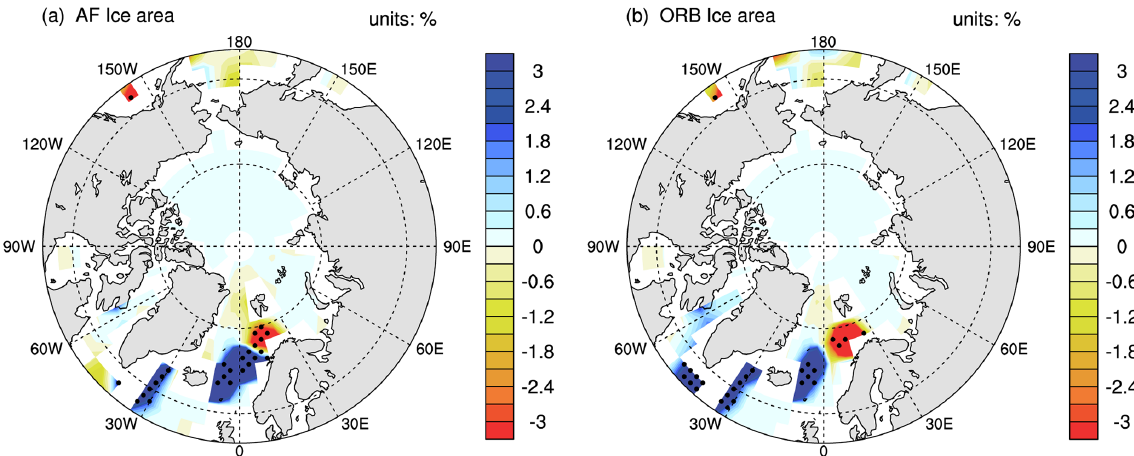
Figure 4. (a) The March sea ice area changes between two period (0–2 and 5–8ka) in the NNU-Hol All forcing simulation (regional average in the Pacific Arctic, 0.02%, and the Atlantic Arctic, 0.29%). (b) Same as (a) but for the ORB forcing simulation (regional average in the Pacific Arctic, 0.04%, and the Atlantic Arctic, 0.29%). Areas that are dotted are significant at the 90% confidence level. The difference in the mean sea ice area changes in the two regions is significant at the 90% confidence level in both AF and ORB.